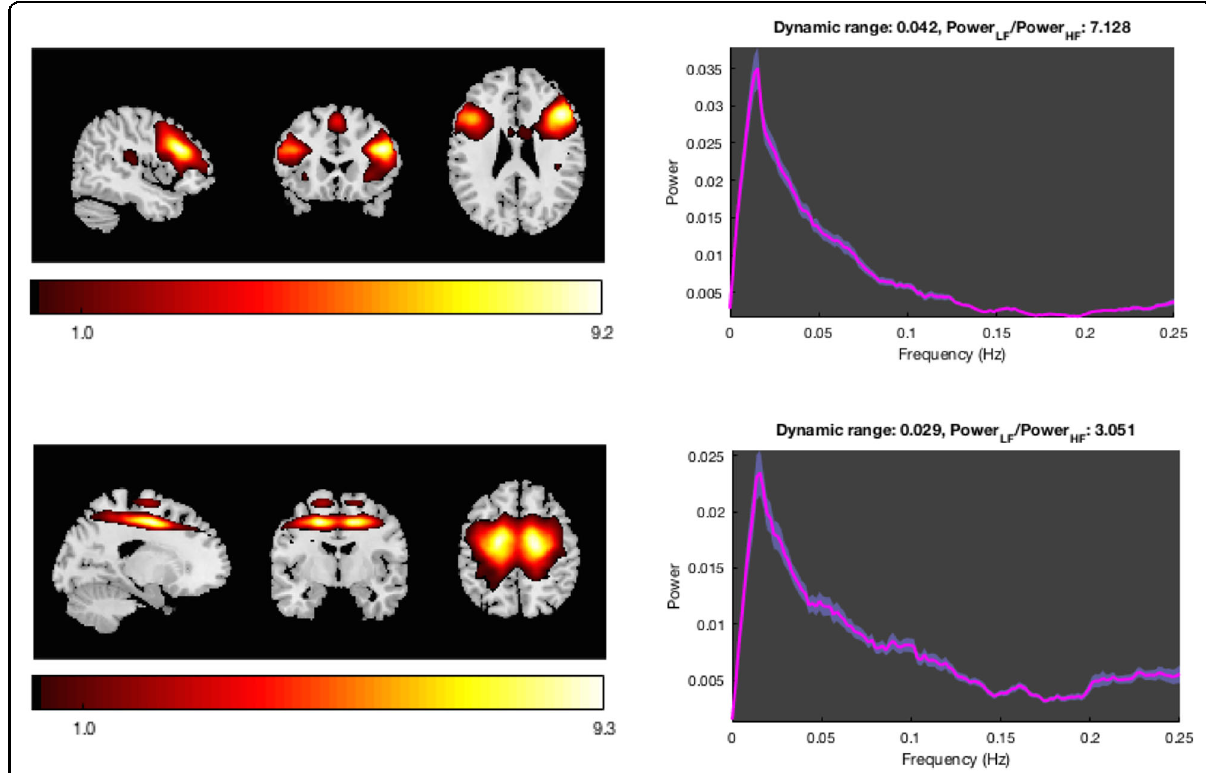
Fig. 2 The Intrinsic Networks 53 (top) and 56 (bottom) encompassing executive networks showed a signi fi cant effect of diagnosis. Spatial maps of the independent component loadings are overlaid on the Montreal Neurological Institute brain template. Average power spectrum for each frequency (Hz) is measured in arbitrary units (a.u.).